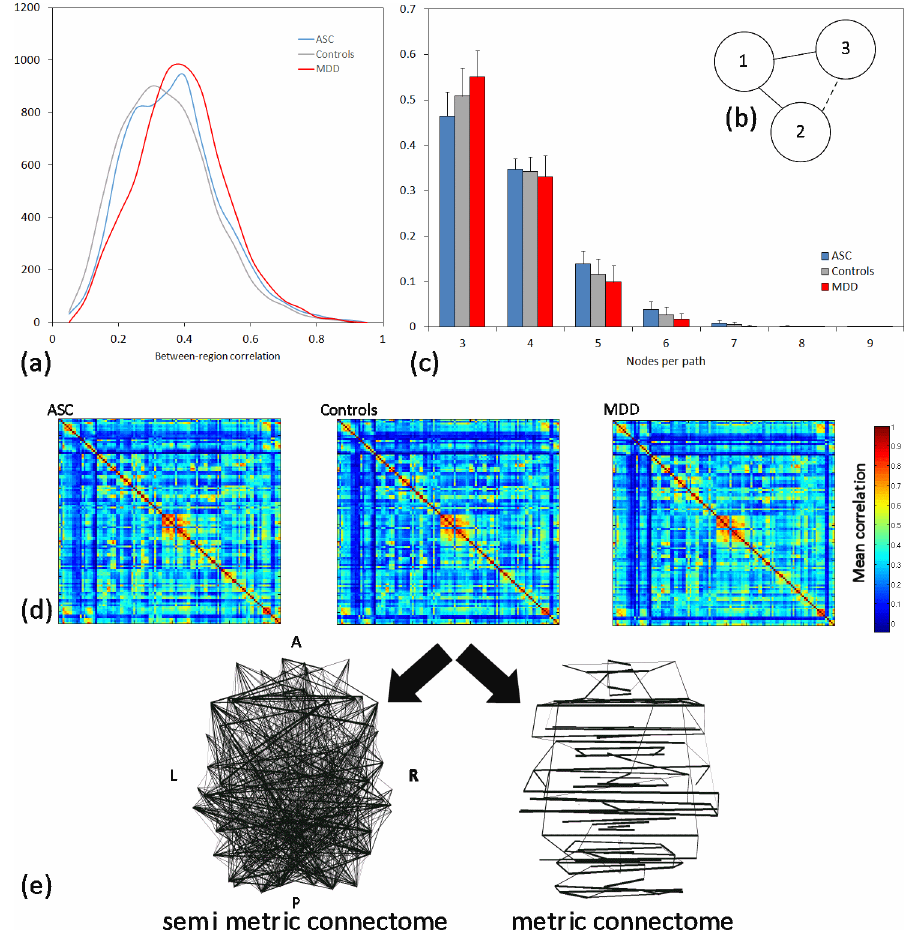
Fig 1. Overview of network properties and analysis. (a) Histogram of correlation coefficients (i.e. edge weights) for each group. (b) Schematic diagram of a simple network with a semi-metric connection between nodes 1 and 2 (dashed edge) due to a shorter indirect path comprising edges between nodes 2 and 3 and 3 and 1 (solid edges). (c) The distribution of number of edges for semi-metric paths for each group. (d) Proximity matrices averaged across participants, for each group. (e) Axial projections of metric and semi- metric backbones for the control group. The thickness of the edges represents the percentage of participants within each group with a semi-metric edge at that location, with percentages > 90%